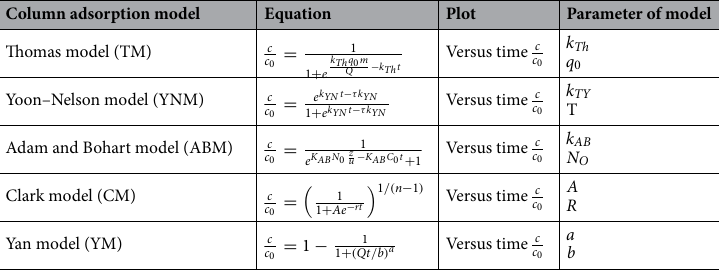
Table 4. Various mathematical models for breakthrough curve